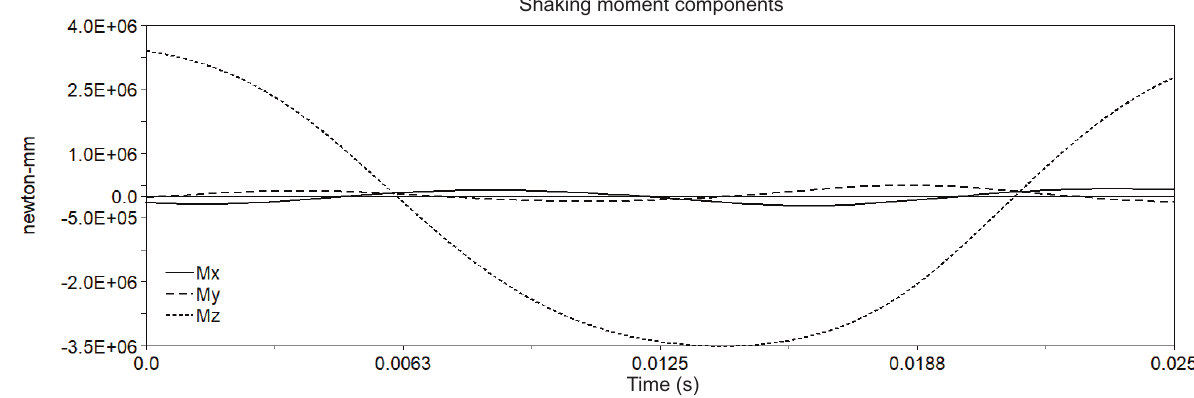
Fig. 3. Total shaking